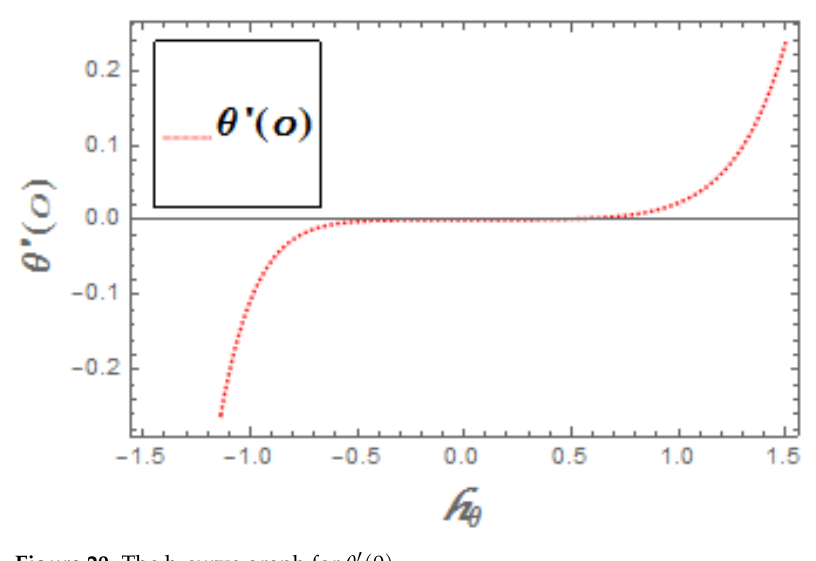
Figure 20. The h-curve graph for θ (cid:48) ( 0 ) .